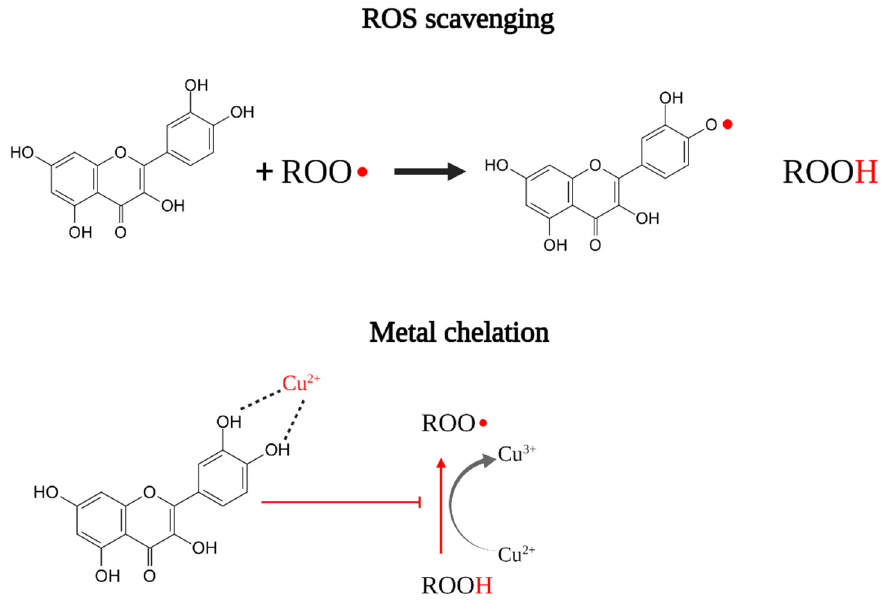
Figure 1. Schematization of direct antioxidant activity through ROS scavenging and metal chelation.